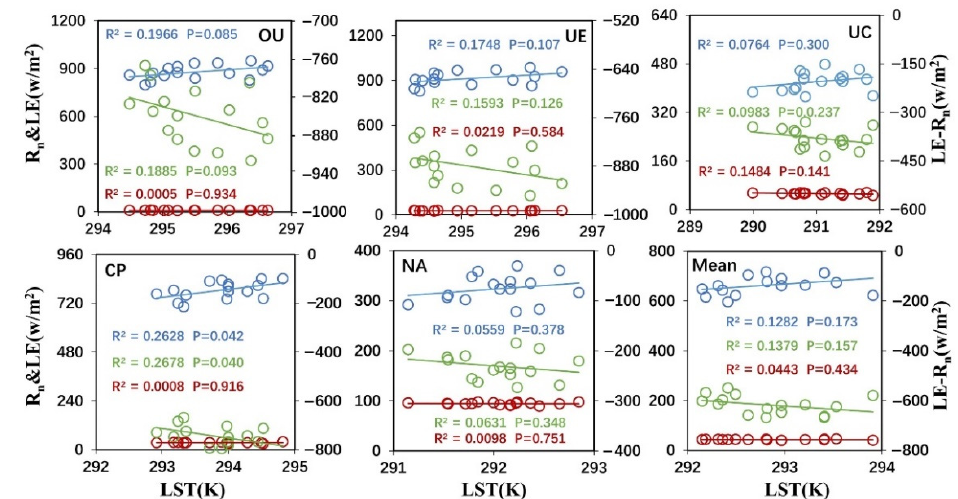
Figure 15. Correlation between LST, R n and LE − R n in the influence area of theYRB from 2000 to 2015 (blue dots and blue lines represent LST and R n scatter plots, red dots and red lines represent LST and LE scatter plots, and green dots and green lines represent LST and LE − R n scatter plots).